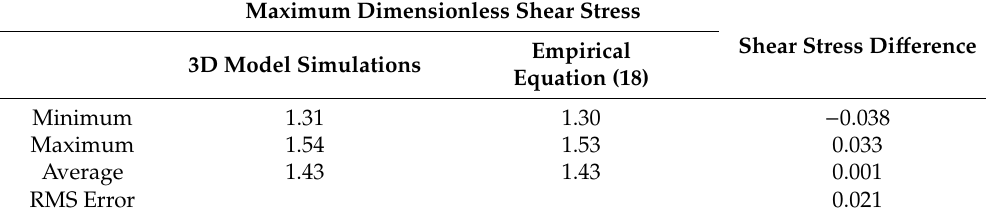
Table 5. Validation of empirical equation to predict maximum shear stress for Simulation Sets 1–3 and 10–12. The di ff erences in shear stress (simulated by the 3D model and computed from Equation (18)) were computed for each channel and the minimum and maximum di ff erences are reported here.